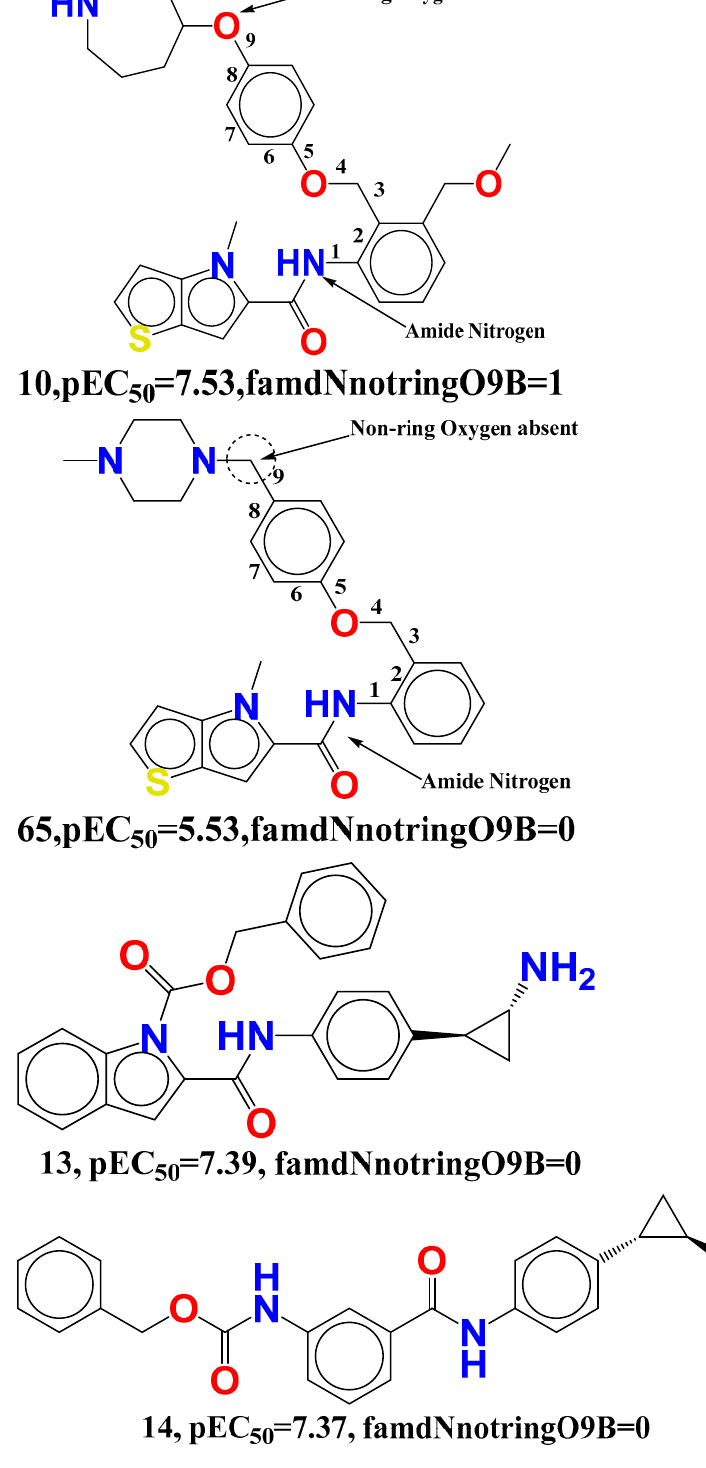
Figure 7. Pictorial depiction of molecular descriptor famdNnotringO9B for the molecules 10, 65, 13, and 14 only.